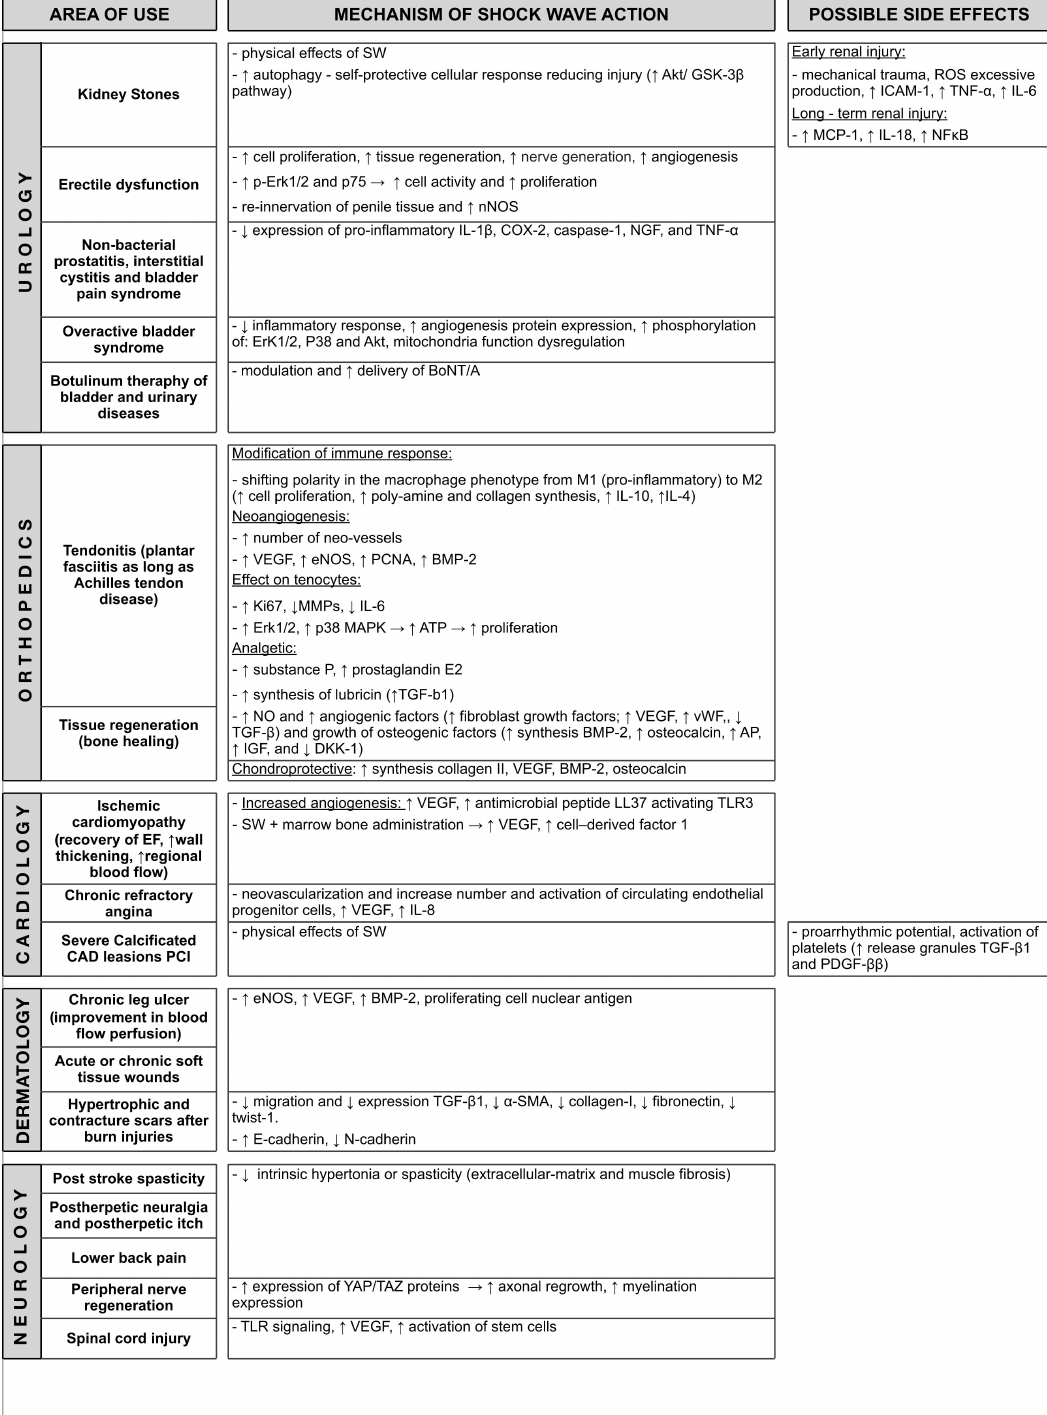
Figure 3. Clinical application and mechanism of action of Shock Wave Therapy. Abbreviations: SW = shock wave; ICAM1 = Intracellular Adhesion Molecule1; TNF- α = Tumor necrosis factor- α ; IL-6 = Interleukin 6; ROS = Reactive Oxygen Species; NF κ B = nuclear factor kappa-light-chain- enhancer of activated B; NOS = nitric oxide synthase; ATP = adenosine triphosphate; TGF = trans- forming growth factors; MMP = matrix metalloproteinase; VEGF = vascular endothelial growth factor; SCDF = stromal cell-derived factor; TLR = Toll-like receptor; SMA = smooth muscle actin; vWF = Willebrand factor; BMP = bone morphogenic protein; IGF = insulin-like growth factor; NO = Nitric Oxide; MCP = monocyte chemoattractant